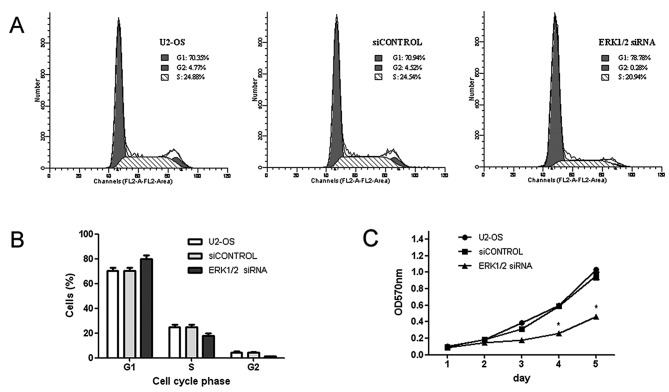
RNAi-mediated downregulation of ERK1/2 reduces U2-OS cell proliferation. (A) Cell cycle analysis of U2-OS was carried out by flow cytometry after 48-h transfection of ERK1/2 siRNA or siCONTROL. (B) Cell proliferation was assessed at the indicated times by MTT assays. Data are from three independent experiments. *P<0.05, **P<0.01 compared to the control group.